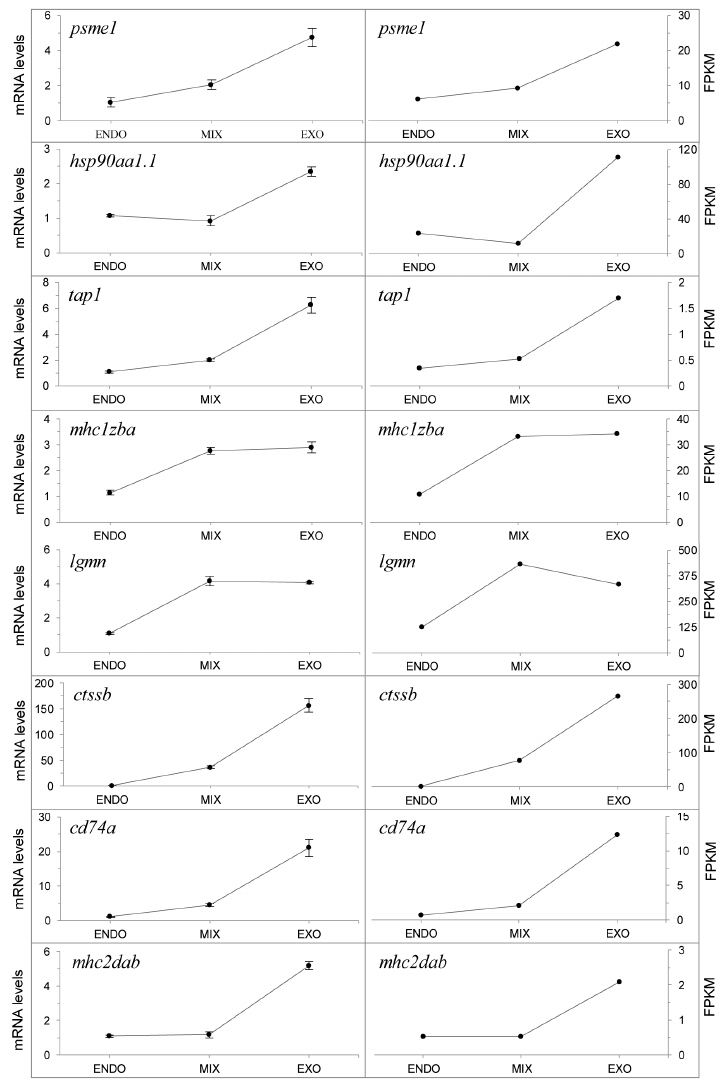
Figure 10. Gene expression levels were revealed by: qPCR ( left ) and RNA-seq ( right ). The proteasome activator ( psme1 ), heat shock protein 90 kDa α ( hsp90aa1.1 ), antigen transporter ( tap1 ), MHC class I ZBA ( mhc1zba ), legumain ( lgmn ), cathepsin Bb ( ctssb ), CD74 molecule ( cd74a ), and MHC class II DAB ( mhc2dab ) were validated. Data from qPCR are shown as mean ± standard deviation ( n = 3). FPKM from RNA-seq are means of two replicates.